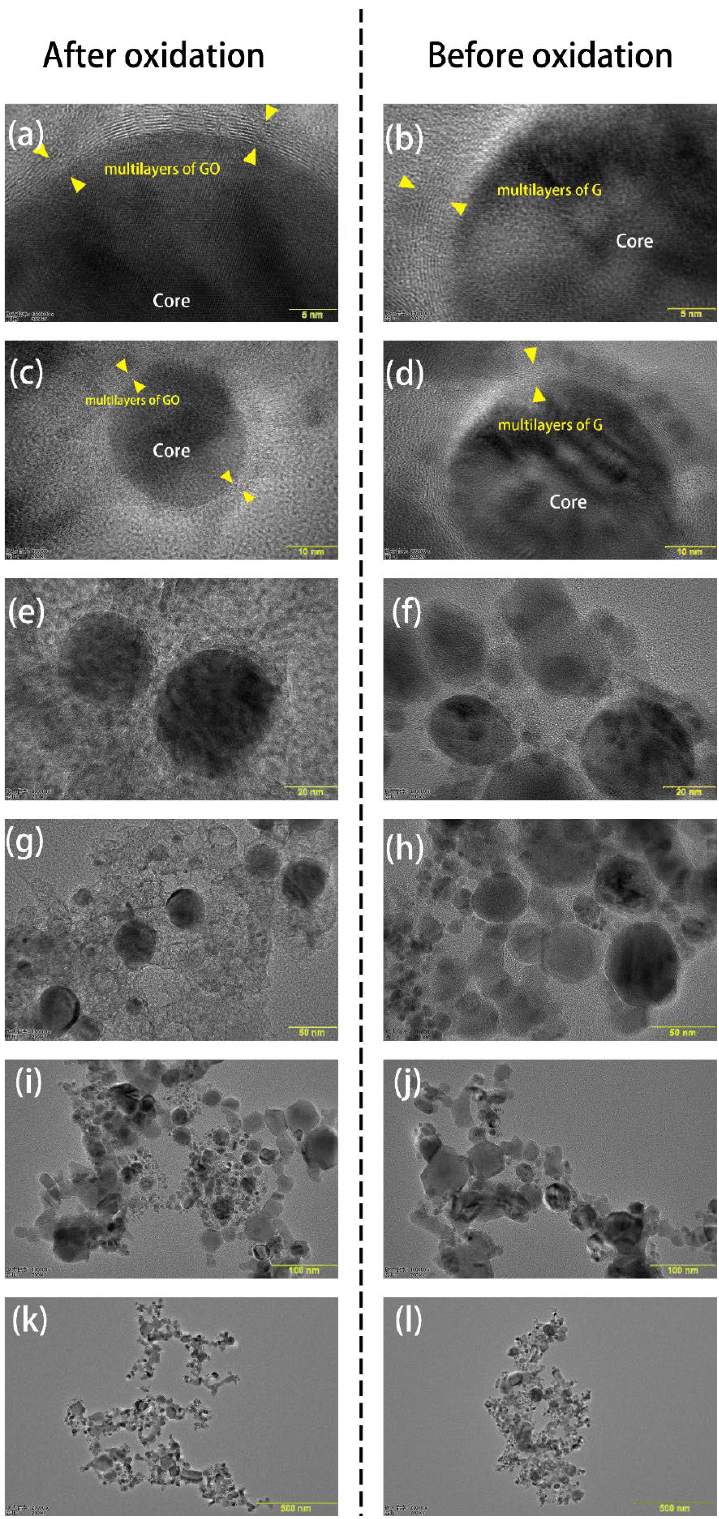
Figure 1. ( a , c , e , g , i , k ) Transmission electron microscopy of GO@FeN-MB; ( b , d , f , h , j , l ) Transmission electron microscopy of G@FeN-MB.